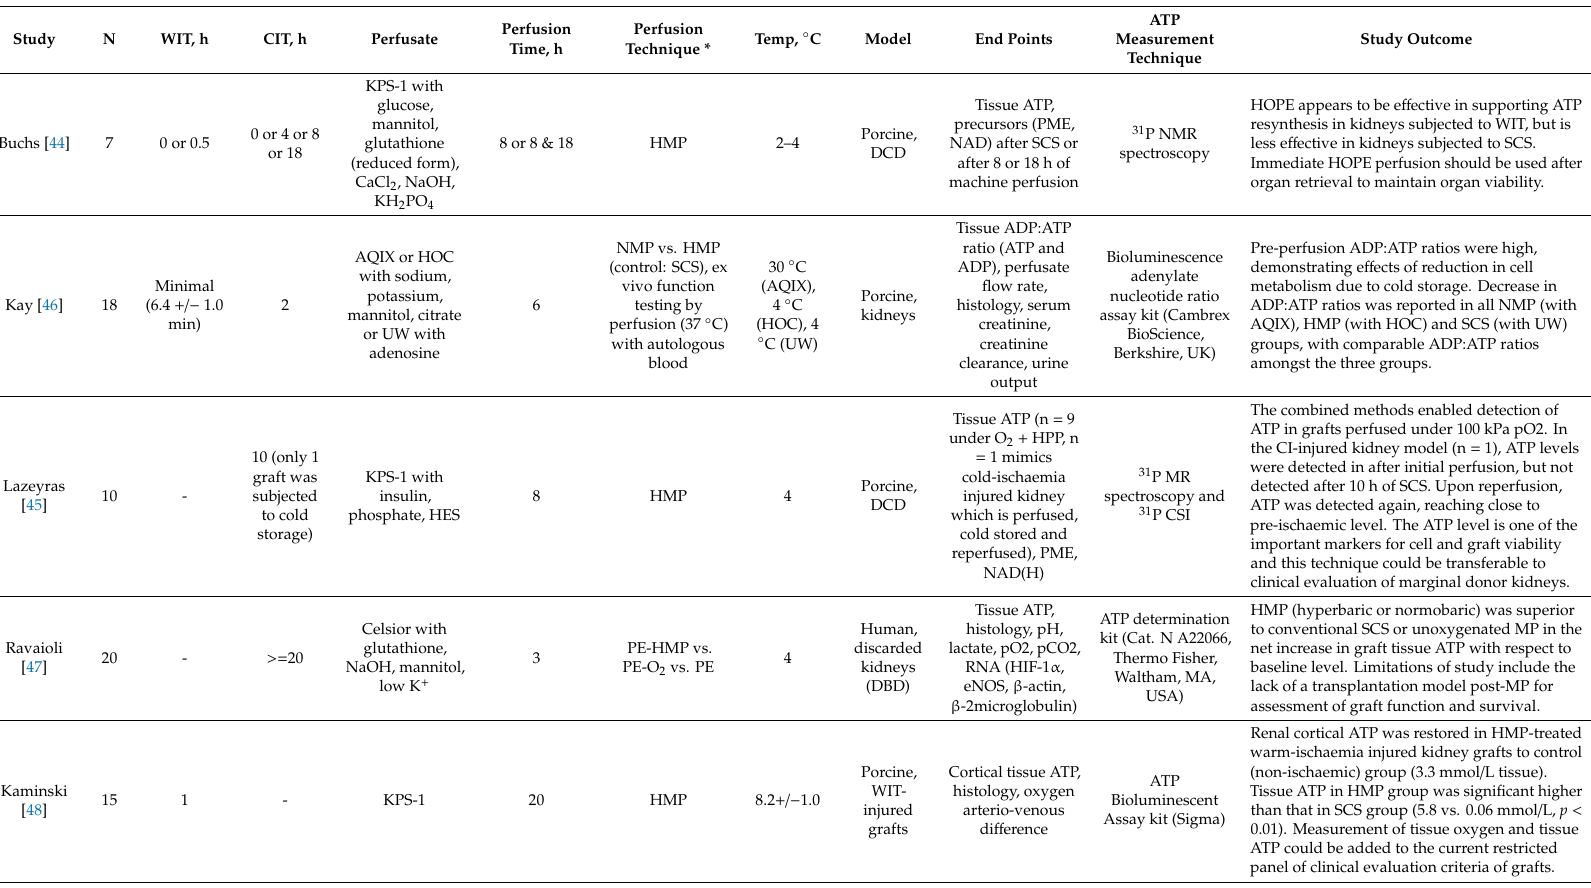
Table 7. Characteristics and outcomes of key pre-clinical and animal studies investigating HMP preservation of